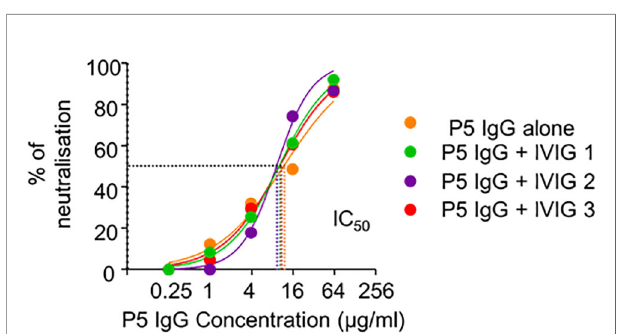
FIGURE 5 | SARS-CoV-2 antibody immunity in pre-COVID-19 era. Neutralisation capacities on the pseudotyped vectors of the IgG isolated from the serum of COVID19 Patient 5 drawn 17 days after symptom onset, diluted with standard diluant (orange) or with each of the three IVIG batches (IVIG-1 in green, IVIG-2 in purple and IVIG-3 in red) with a fi nal IVIG IgG concentration of 12 mg/mL in the neutralisation assay. Half maximal inhibitory concentrations (IC 50 ) of patient ’ s serum alone (11.67 µg/mL) or diluted with IVIG batch 1 (9.94 µg/mL), IVIG2 (9.14 µg/mL) and IVIG3 (10.15 µmg/mL) are shown with dotted